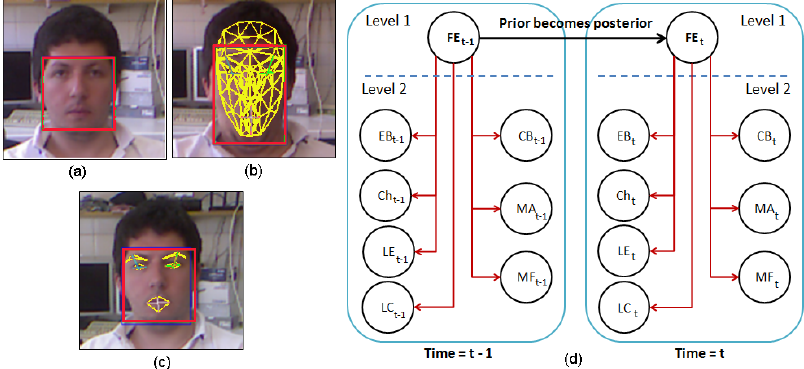
Figure 11. ( a ) RGB image of the user acquired by the sensor; ( b ) Candide-3 reconstruction model; ( c ) features extracted from the mesh model; and ( d ) dynamic Bayesian network; two time intervals are